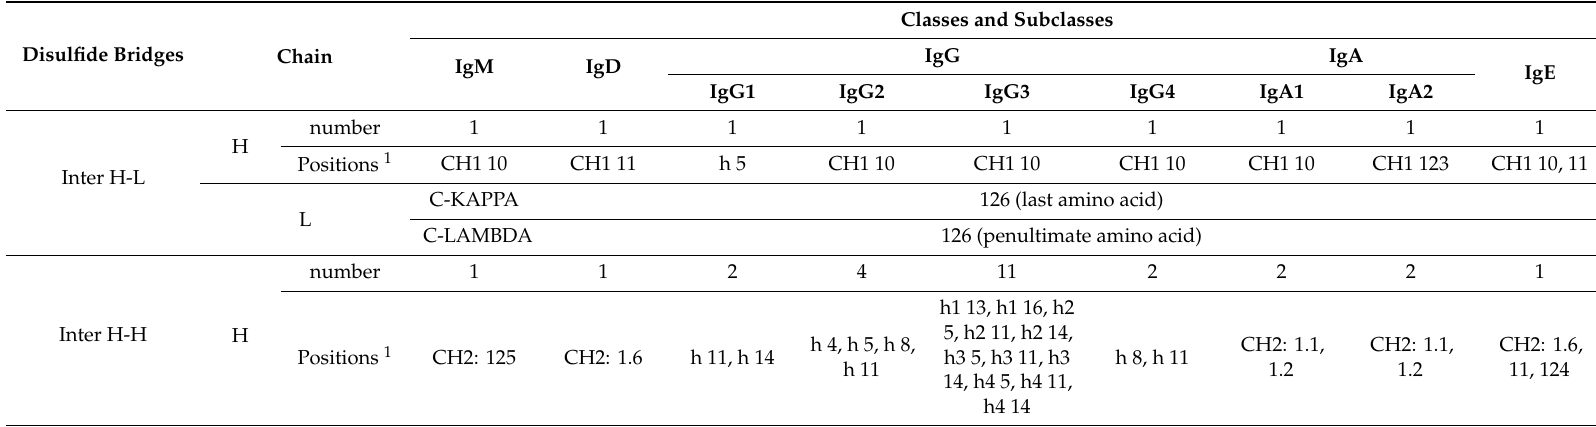
Table 4. Interchain disulfide bridges. The number of inter Heavy (H)-Light (L) and inter H-H disulfide bridges is given per monomer of human ( Homo sapiens ) IG classes and subclasses, with positions of the cystein in the domain (IMGT unique numbering for C-DOMAIN [42]).